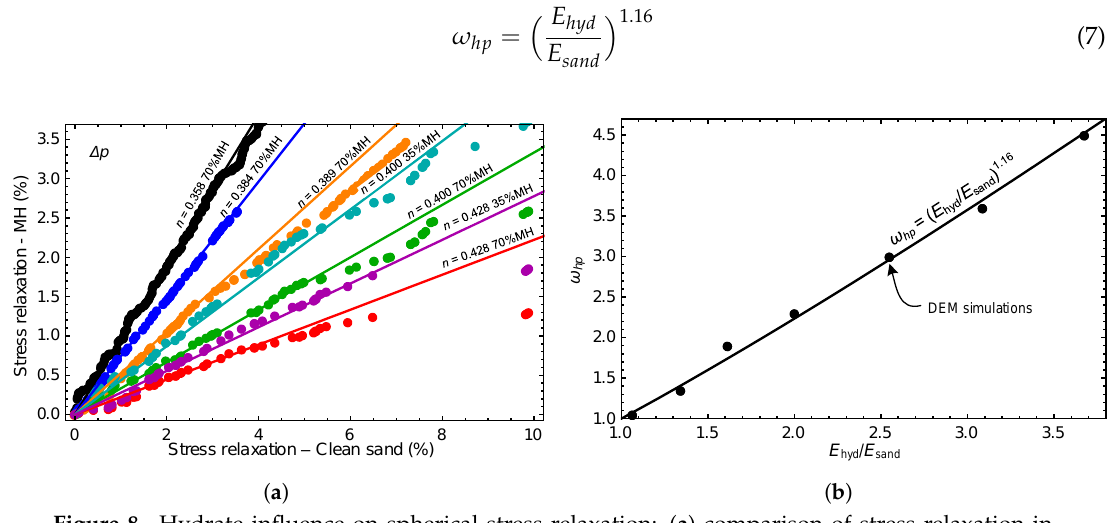
Figure 8. Hydrate influence on spherical stress relaxation: ( a ) comparison of stress relaxation in clean sand samples and MH samples under equal detached mass. Colors represent different porosity and MH participation factors (dots = DEM simulations, lines = fitted linear relations); ( b ) ω hp as a function of the stiffness ratio of hydrate-bearing sediment to clean sand (dots = DEM simulations, line = fitted